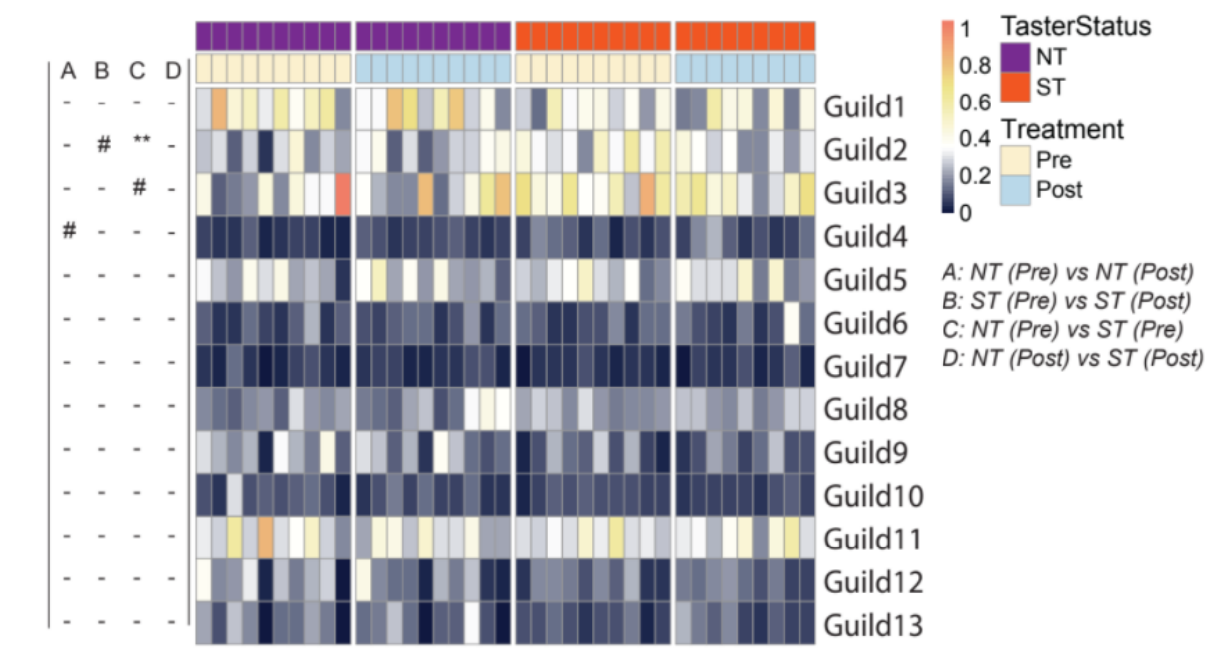
Figure 4. Heatmap showing guild-level differences in the oral microbiome pre- and post- intervention in PROP taster groups. The color of the heatmap represents the abundance of each guild in each sample (arcsine square-root transformed). The left panel shows comparisons between pre- and post- treatment samples in PROP taster groups (A and B) or between NT and ST subjects at the same timepoints (C and D). In NT/ST subjects, Wilcoxon matched-pairs signed-ranks test (two-tailed) was performed to compare pre- and post- treatment samples. Pre-/Post- intervention, Mann-Whitney test (two-tailed) was performed to compare NT and ST subjects. - p ≥ 0.1, # p < 0.1 and ** p < 0.01. ‘ - ’ indicates no difference between NT and ST subjects. Pre-intervention, NT n = 10, ST n = 10; Post- intervention, NT n = 10, ST n = 9.